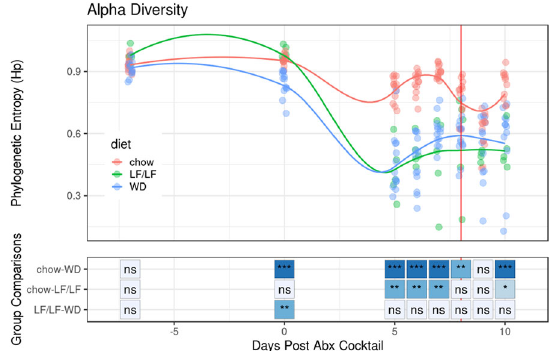
Fig. 6 Alpha-diversity (phylogenetic entropy) of the fecal micro- biome during murine CDI model. Data for each individual mouse is plotted as well as the fi tted local polynomial regression for each diet group. Signi fi cant differences between diet groups were calculated by Kruskal – Wallis followed by Dunn ’ s post hoc test. * p < 0.05, ** p < 0.01, *** p <